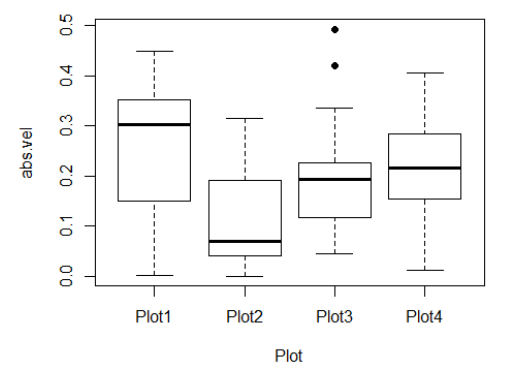
Figure 8. Flow velocity (absolute values) in each plot.